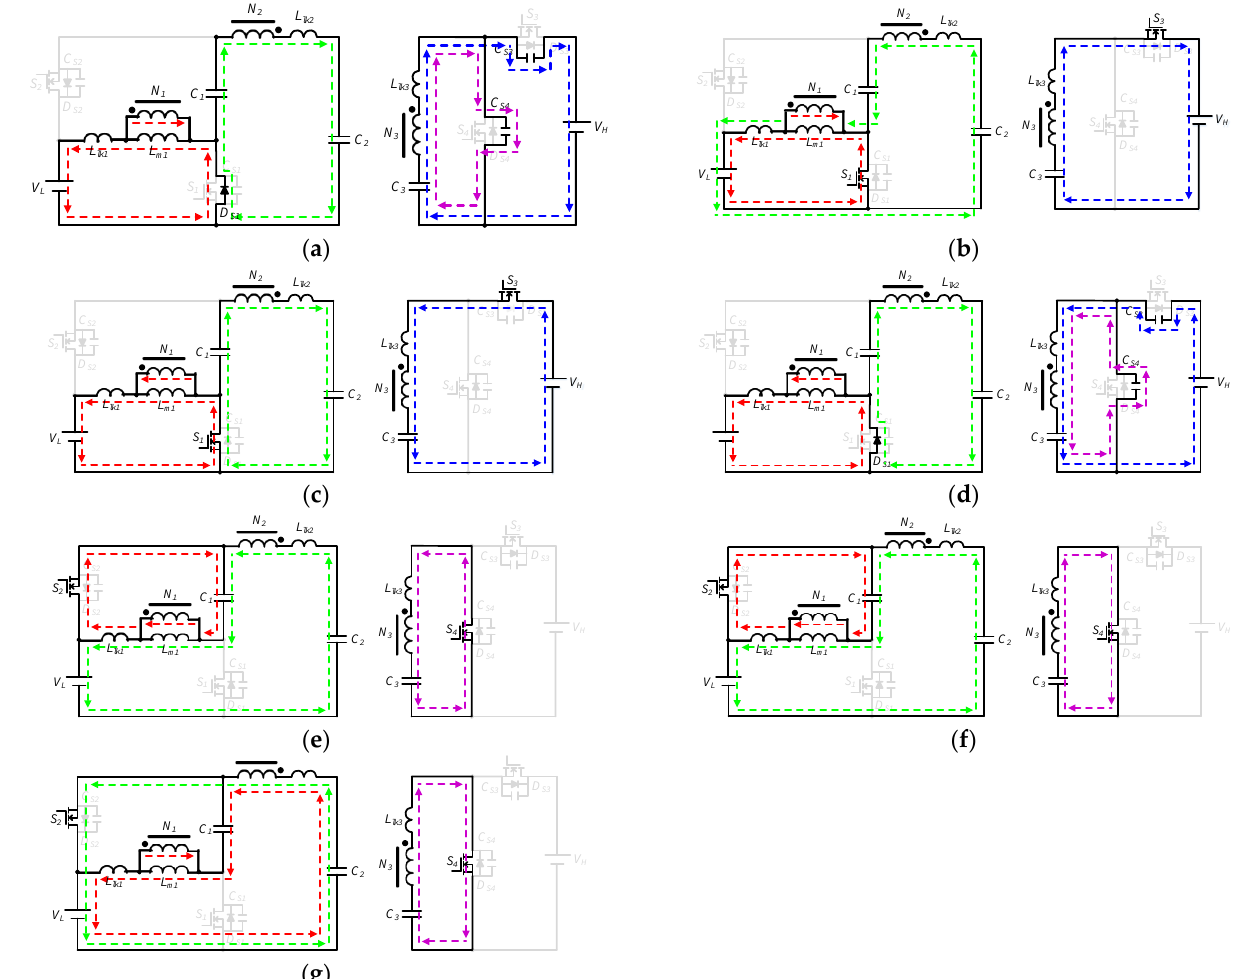
Figure 7. Equivalent circuit diagrams of ( a ) mode 1, ( b ) mode 2, ( c ) mode 3, ( d ) mode 4, ( e ) mode 5, ( f ) mode 6, and ( g ) mode 7 in the step-down mode.